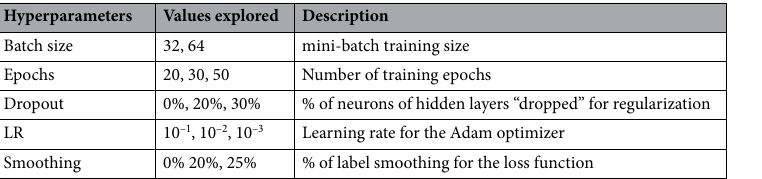
Table 5. Hyperparameters for the ResNetV2 base model.